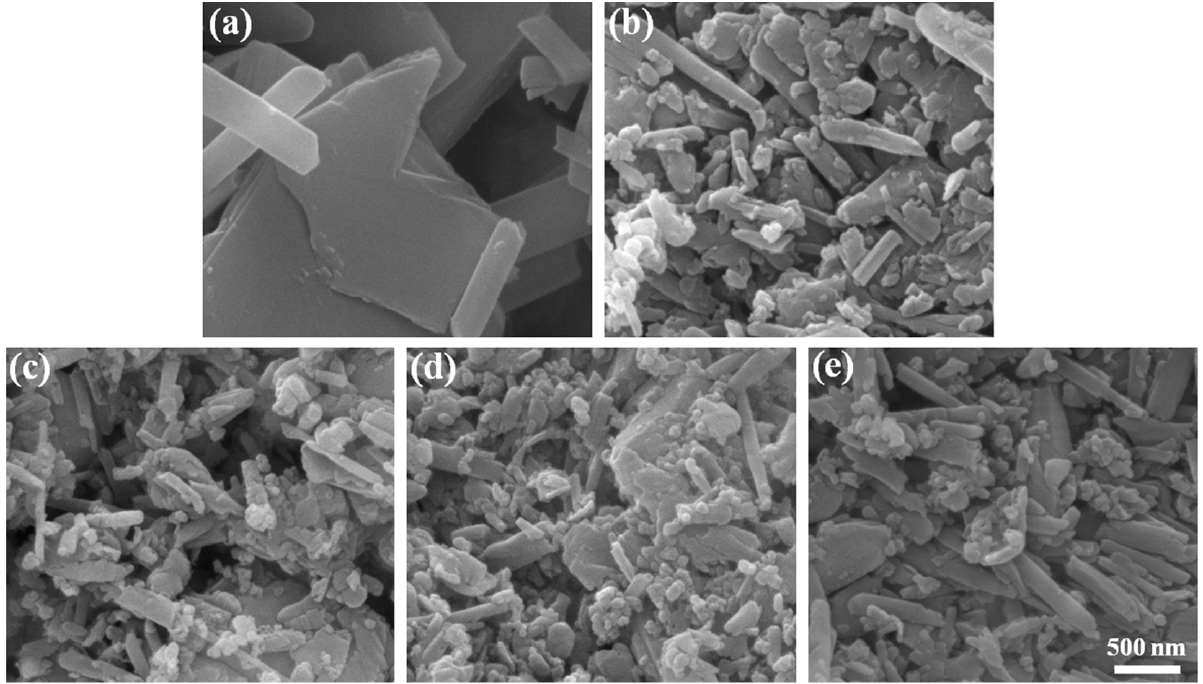
Figure 2. The SEM images of the pure HNTs and the HNTs@AlPO 4 nanocomposites as synthesized. ( a ) HNTs, ( b ) HNTs@AlPO 4 I, ( c ) HNTs@AlPO 4 II, ( d ) HNTs@AlPO 4 III, and ( e ) HNTs@AlPO 4 IV. The scale bar in the last image can be applied to the other images.